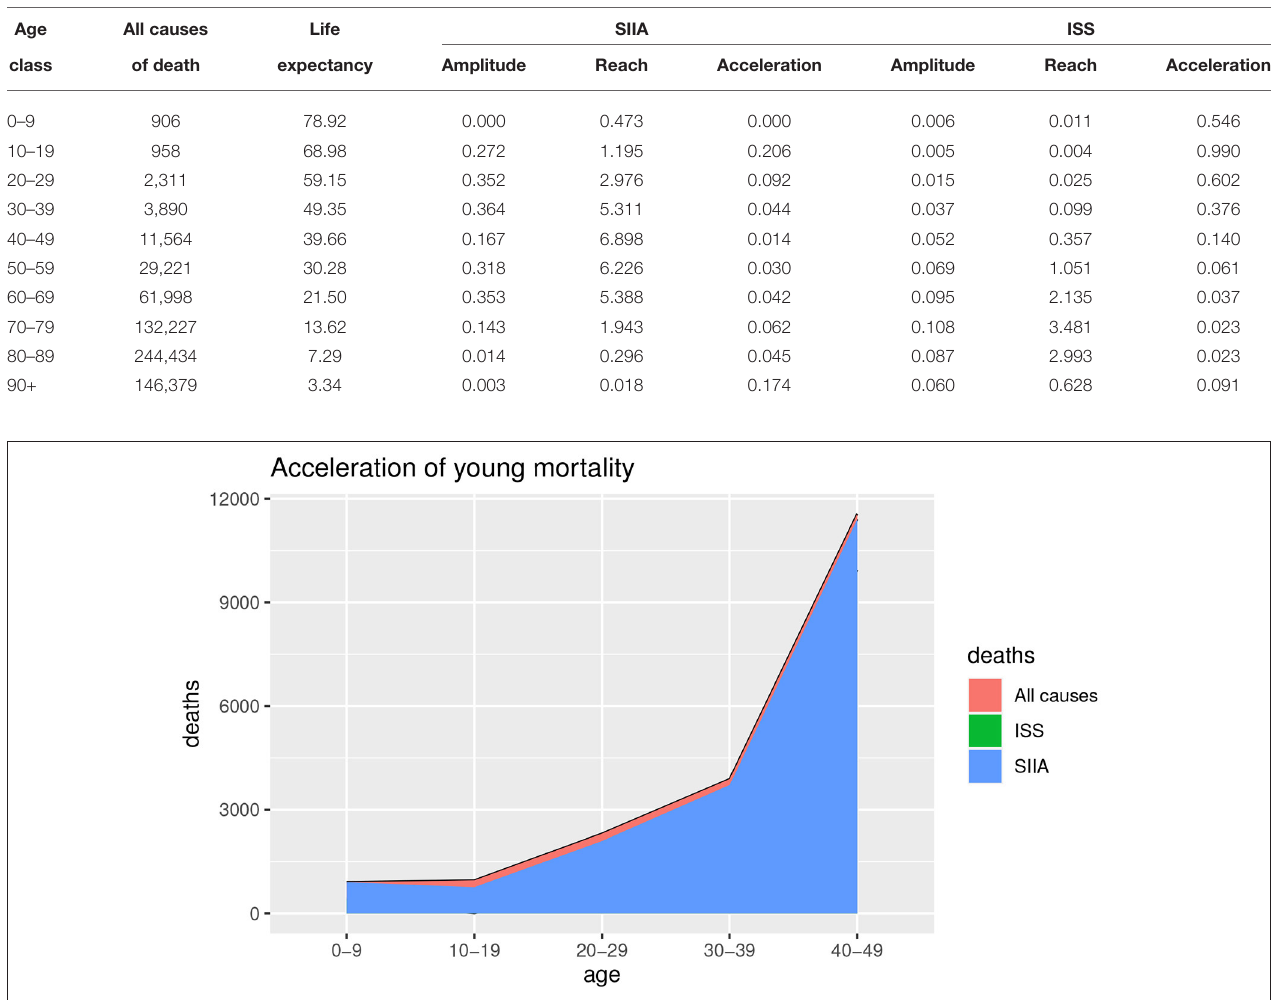
TABLE 2 | Estimation of amplitude, reach, and acceleration.